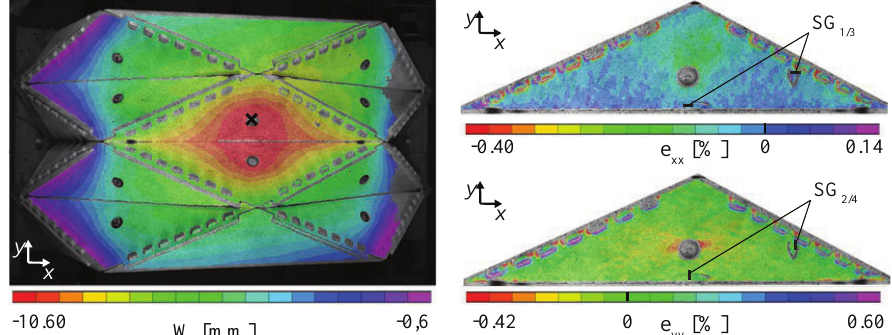
Figure 5. MTSJ open slot structure, displacement field ( left ) and strain field of one plate ( right ) are shown at the moment when the total load on the structure amounted to 25 kN, which approximately corresponds to the occurrence of SLS maximal allowed displacements. Positions of strain gauges used for validating the DIC obtained strains in the x - and y -directions are shown on plate respective strain fields ( right ).